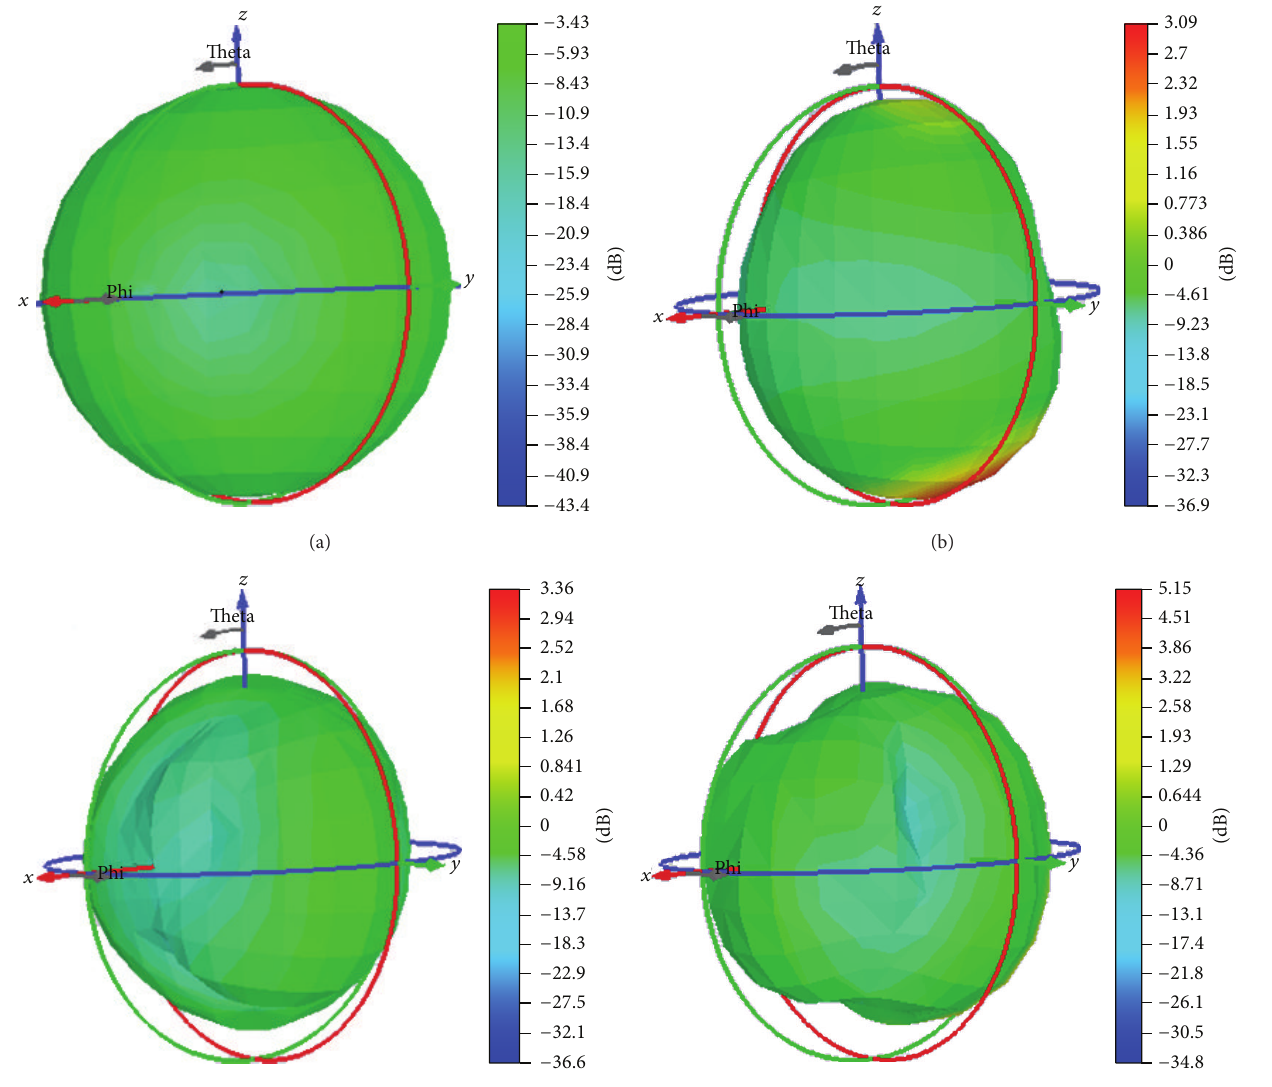
Figure 8: Simulated 3D far-field radiation patterns at specific frequencies: (a) 3.17 GHz, (b) 7.32 GHz, (c) 9.97 GHz, and (d) 12.16 GHz.